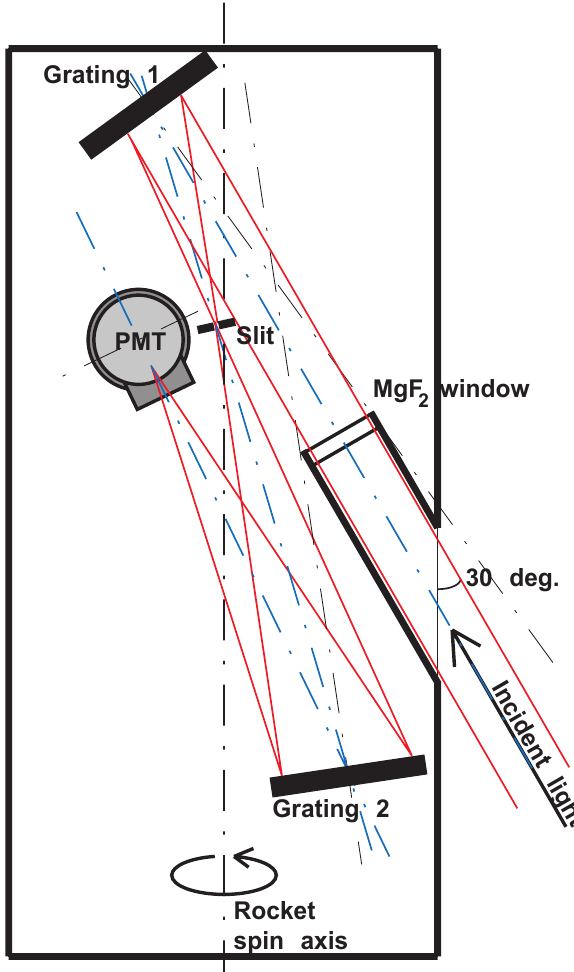
Fig. 8. Schematic of the SLAM grating instrument. The instrument is downward viewing with the opening tilted 30 ◦ from the rocket spin axis. Light enters through a MgF 2 window and is reflected on the first grating. A slit transmits the -1 order diffracted light to the second grating. The CsI photomultiplier tube (PMT) is positioned to receive the − 1 order diffracted light from the second grating. The entrance aperture is 4cm 2 and the field-of-view is 2 ◦ by 10 ◦ , or 6.1 × 10 − 3